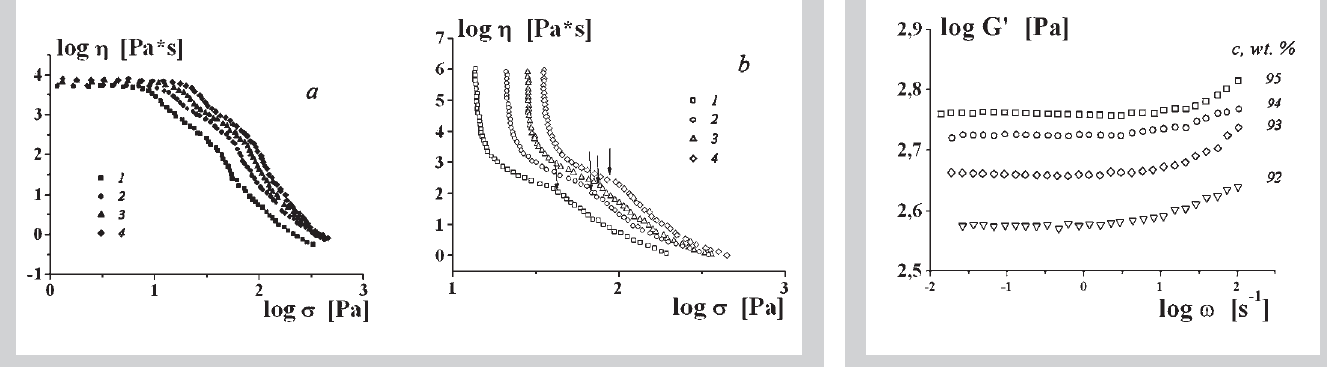
Figure 3 (left): Flow curves of emulsion of different concentrations: 1) 92 wt%, 2) 93 wt%, 3) 94 wt%, and 4) 95 wt% as measured in downward shear rate sweep mode. Figure 4: Frequency dependencies of storage modules for emul- sions of different concentra-